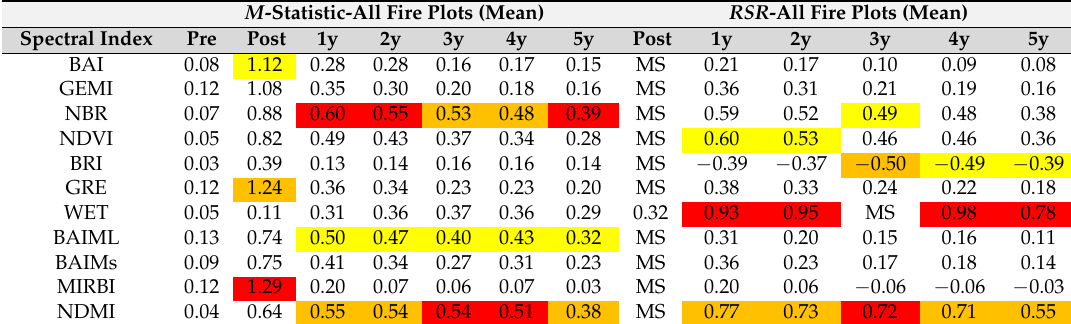
Figure 4. Spectral Indices’ trajectories over time: pre- and post-fire, and 1, 2, 3, 4, and 5 years following the fire. The plots represent the SI mean values for the burned and the reference samples of the whole dataset. Table 3. Separability index ( M -statistic) and Residual Severity Ratio ( RSR ) for the 11 SI. Highlighted cells indicate the three best performers at the given post-fire time in the following rank/color order: 1st, 2nd, 3rd. Pre-fire M -statistic values are shown as reference. MS = maximum severity from which RSR is calculated. Negative values of RSR indicate that the trajectory of the burned class crossed the trajectory of the unburned control class. M -Statistic-All Fire Plots (Mean) RSR -All Fire Plots (Mean)